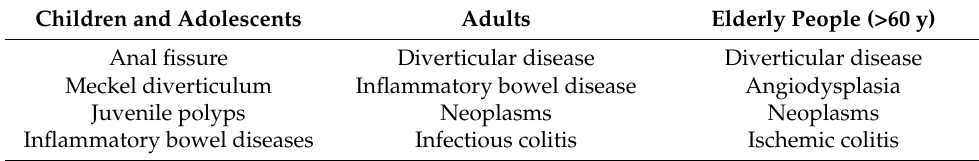
Table 5. Common causes of lower gastrointestinal bleeding according to age